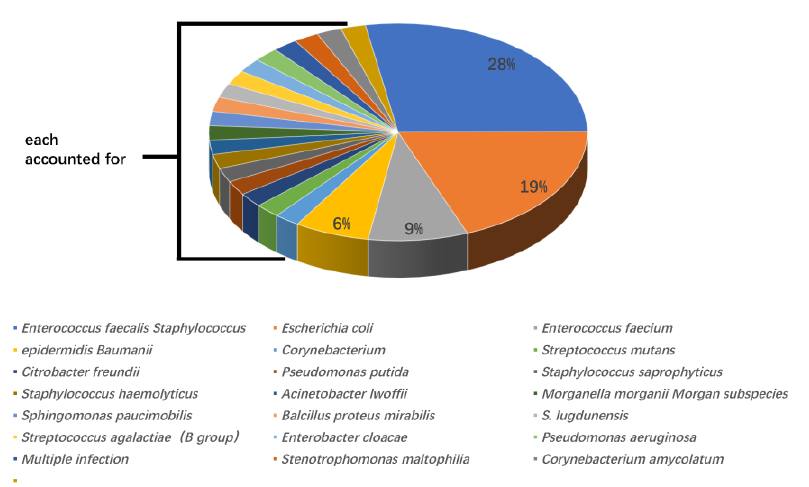
Figure 1. The genera and proportions of bacterial strains from patients with positive urine cultures.